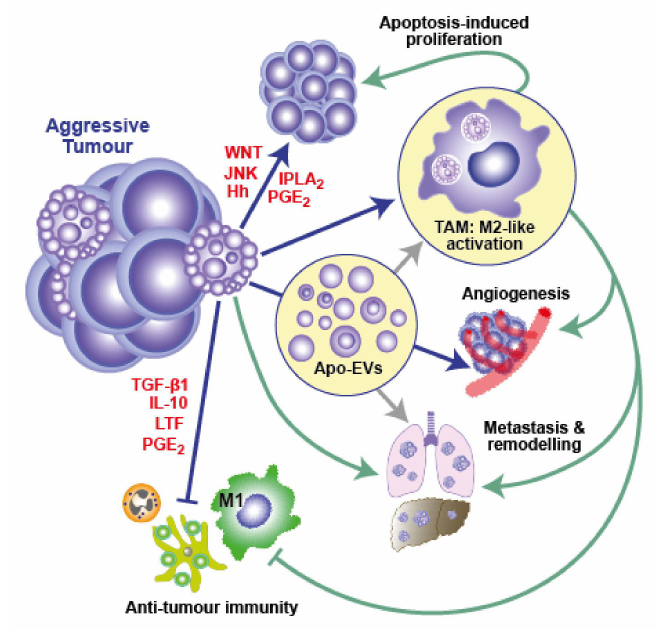
Figure 2. Pro-oncogenic effects of apoptosis and the concept of the Onco-Regenerative Niche (ORN). Apoptotic tumour cells have broad effects on the tumour population as a whole and provide the driving force in a conceptual sub-sector of the tumour micro-environment, which we have termed the ORN. Solid blue arrows and associated molecules highlight proven pathways that we and others have elucidated in recent years. Green lines indicate putative pathways in the ORN that we have identified through in situ transcriptomics of TAMs. Grey arrows indicate potential functional pathways of Apo-EVs. See text for further